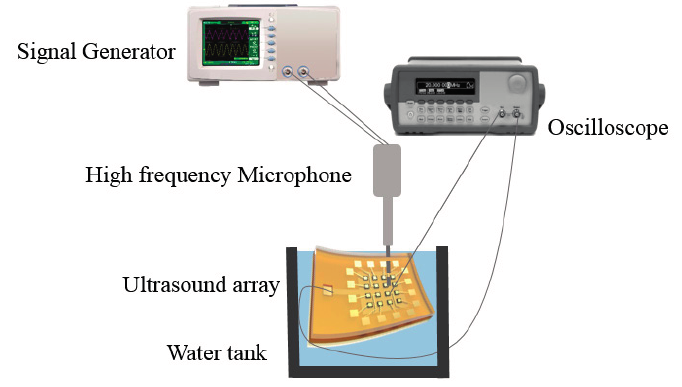
Figure 6. The schematic diagram of the test. The whole device tested in the water tank without any waterproof